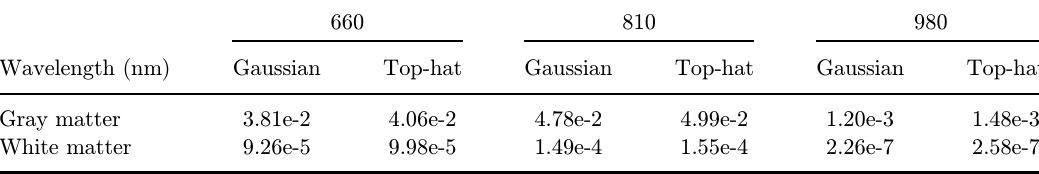
Table 3. Accumulated °uence of light-penetrated voxels within brain tissue. Std < 0 : 01 %Mean